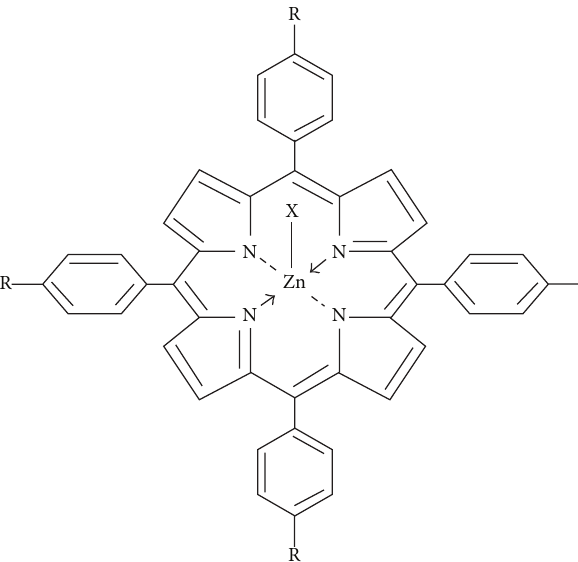
Figure 8: Proposed structure of axially ligated zinc(II)